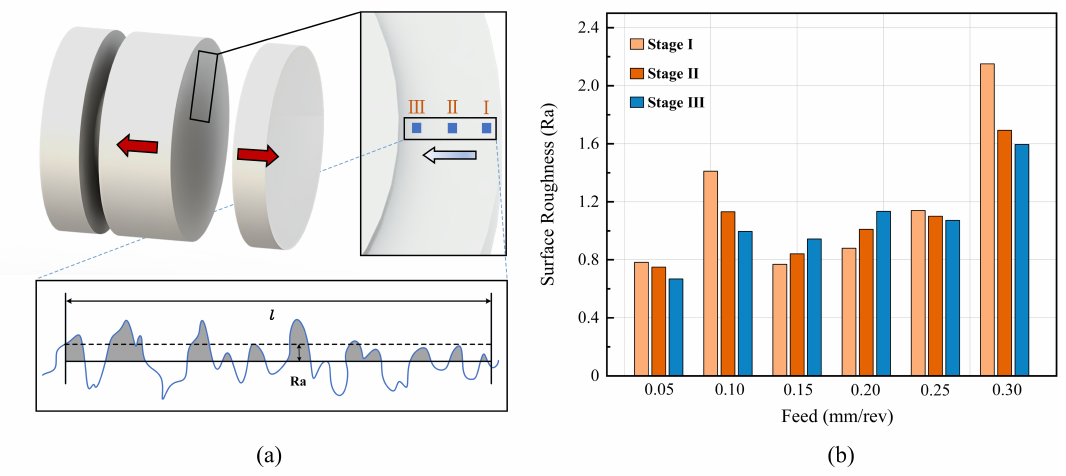
Figure 6. Analysis of surface roughness: ( a ) sample preparation and selection of detection area and ( b ) variation of surface roughness with respect to feed rate at various cutting